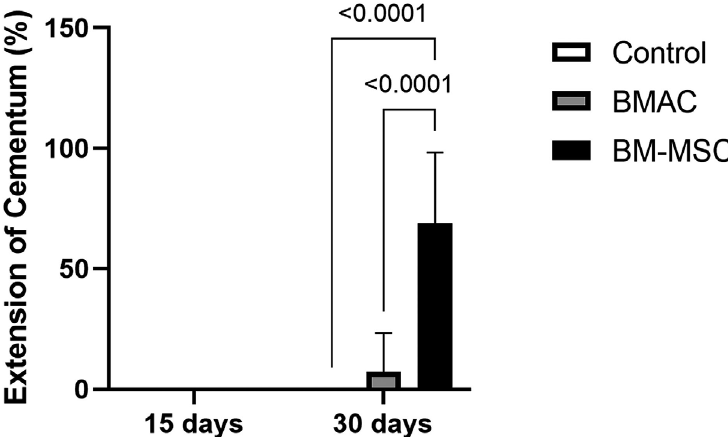
Figure 5- Histogram reporting the histomorphometry analysis of cementum extension (%) - a linear extension of the new cementum in the total extension of the distal root of the first molar - at postoperative 15 and 30 days. Filling with BM-MSCs affects cementum formation within 30 days. Means and standard deviations of the groups at different experimental times: 15 days: no cementum-like tissue was observed in any group; 30 days: Control (zero), BMAC (7.2±16.10), BM-MSCs (68.83±29.53)